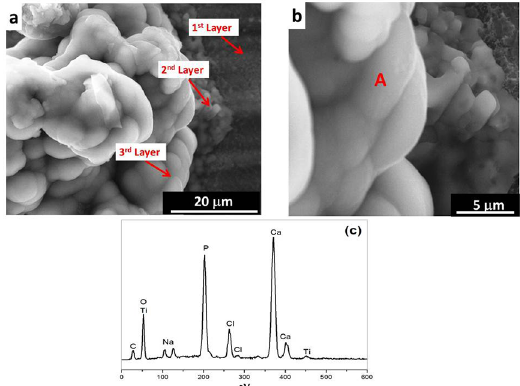
Figure 3. (a) and (b) Micrograph of cp-Ti at C0 (cp-Ti+ HA), obtained by SEM. (c) Spectrum obtained in the microanalysis by EDS at point A.